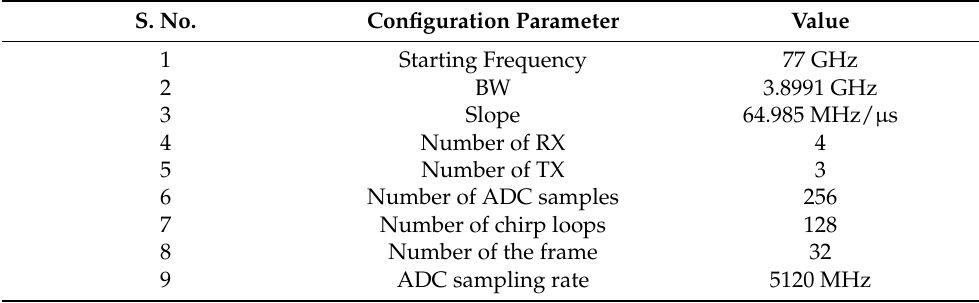
Table 1. Configuration parameters of the radar module.